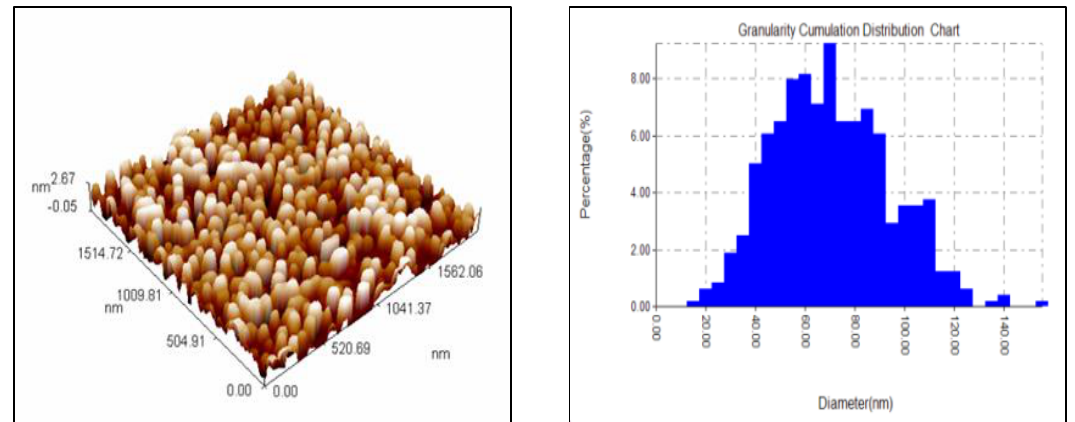
Figure 3: AFM results of prepared Ag NPs by chemical reduction method with 5 min as a reduction period